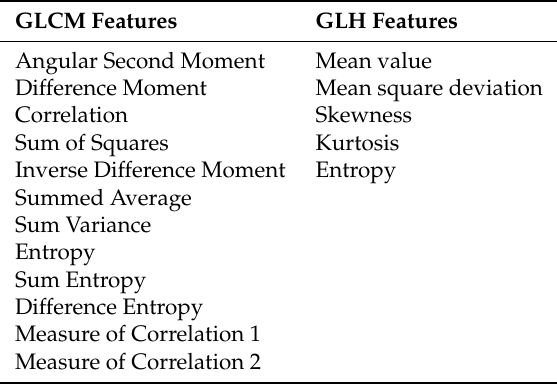
Table 2. The statistical measures derived from GLCM and GLH, respectively, and extracted in order to perform “Spatial” extraction